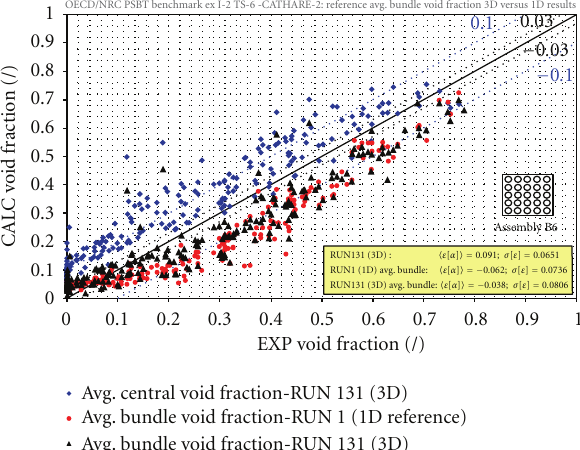
Figure 4: Test Series 1 (tests 1.5222 and 1.5223)—CATHARE2 code, nodalization e ff ect.